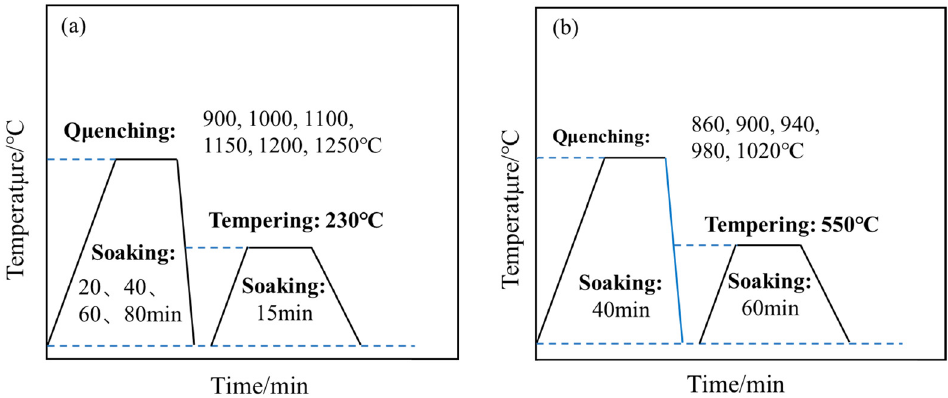
Figure 1: Di ff erent heat treatment regimes in the experiment: ( a ) schematic diagram of austenite grains sample treatment process and ( b ) di ff erent quenching processes for the impact tests.